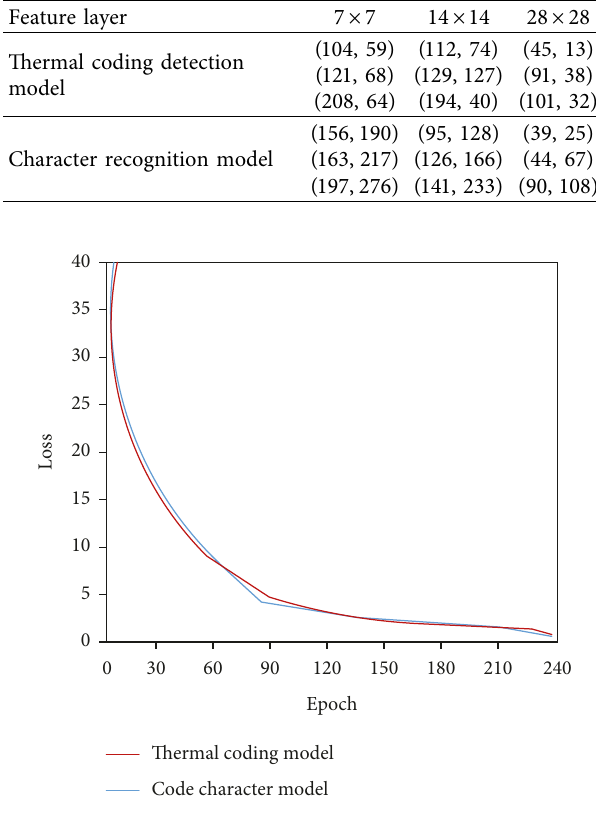
Figure 5: Learning curve of lightweight YOLO model.